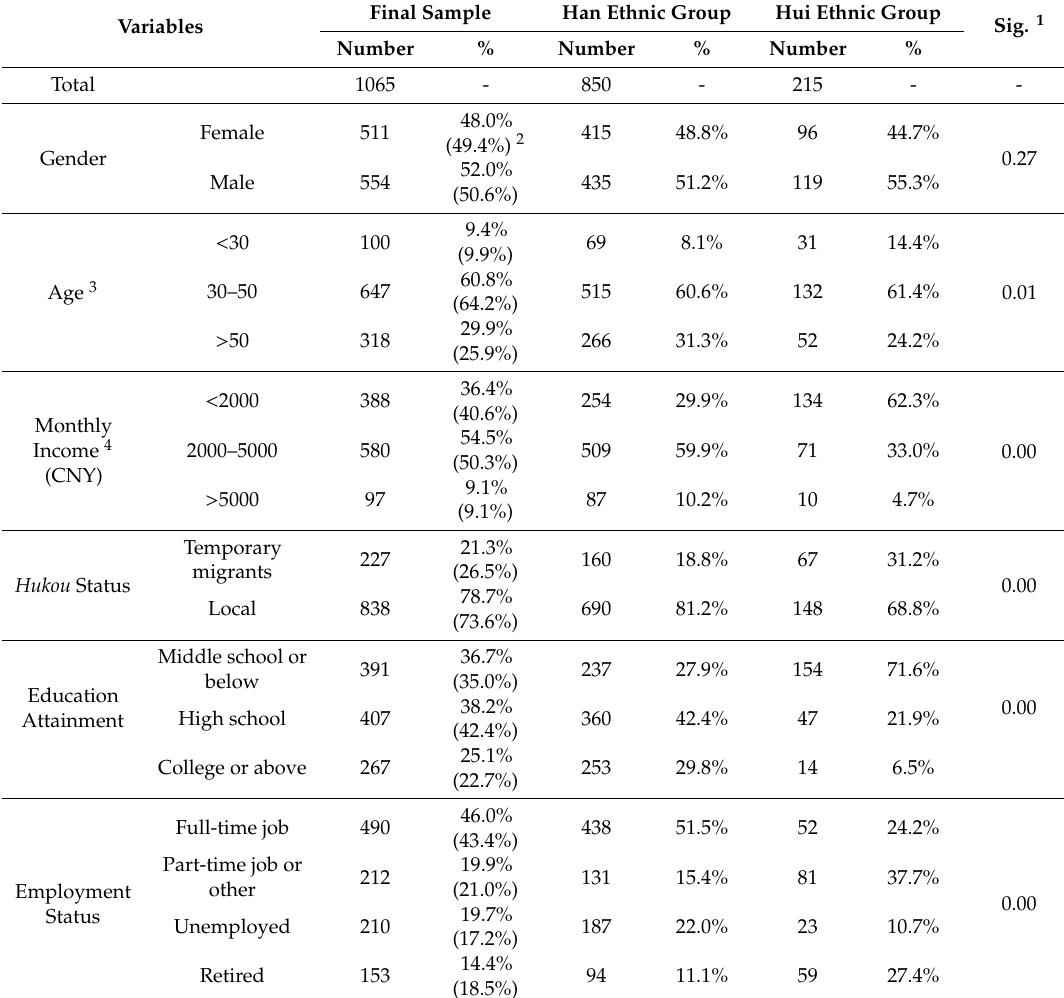
Table 1. Characteristics of the participants in the